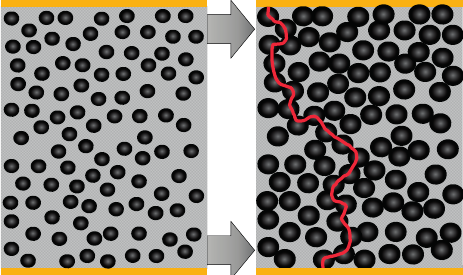
Figure 4. Scheme to illustrate how the volume increase during sulfidation of the dispersed nickel catalyst influences the electrical